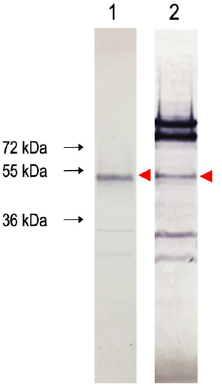
Figure 1. Western blotting images showing the purified rNP and rMLD proteins. Lane 1: rNP protein with a theoretical molecular weight of ~ 53.9 kDa; Lane 2: rMLD protein with a theoretical molecular weight of ~ 53.67 kDa. Western blot images are obtained from separate blots and delineated with white space. Arrowheads next to each blot show the place of purified recombinant proteins. Original Western blot images of Lane 1 and 2 are shown in Supplementary Figs. S3 and S4, respectively.